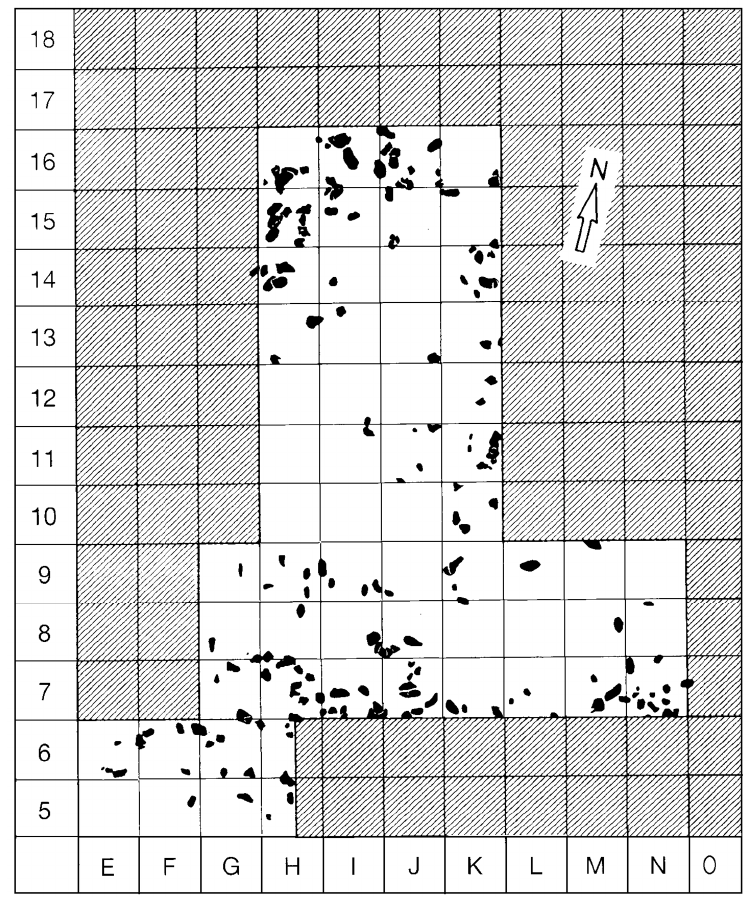
Figure 13. Dorn-Dürkheim 3. Distribution of molares from Mammuthus trogontherii . (After J.L. Franzen in Fiedler and Franzen 2002).